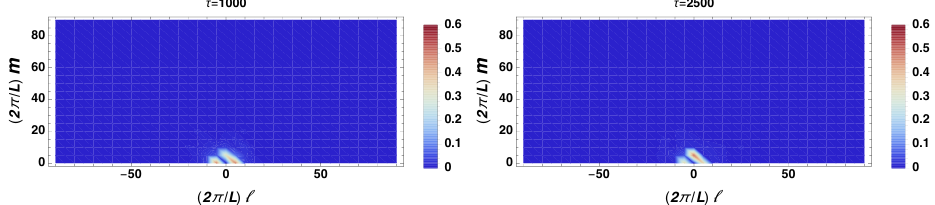
Figure 6. Case A2—inviscid. Contour plots of | ξ (cid:96) , m | taken at distinct times as indicated over the graphs.